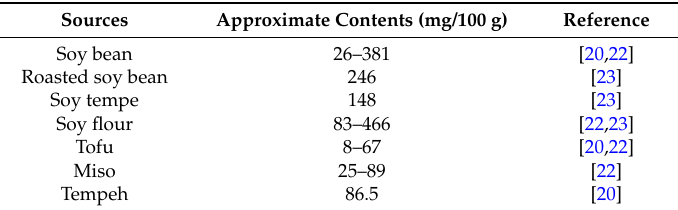
Figure 1. Structure of isoflavones and estradiol. Table 1. Approximate content of isoflavones in main